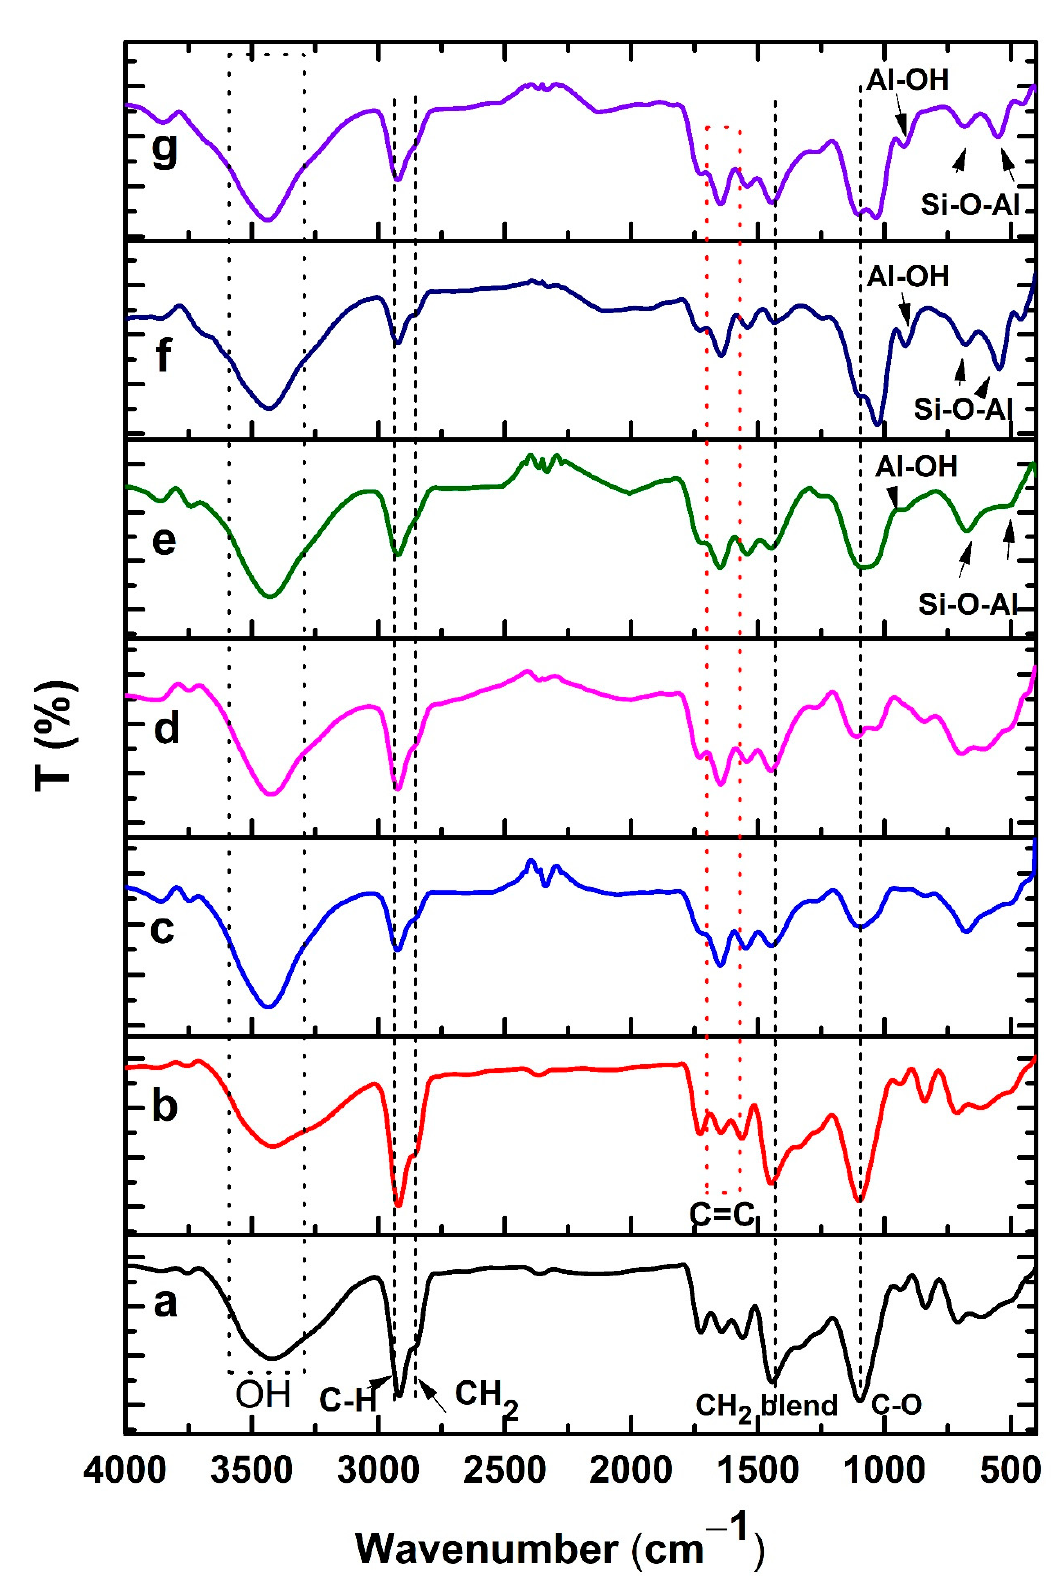
Figure 2. FT-IR spectra of ( a ) PVA, ( b ) PVA-M0.1, ( c ) PVA-M0.25, ( d ) PVA-M0.5, ( e ) PVA-M0.5-K0.1, ( f ) PVA-M0.5-K0.25, and ( g ) PVA-M0.5-K0.5 composite sponges.